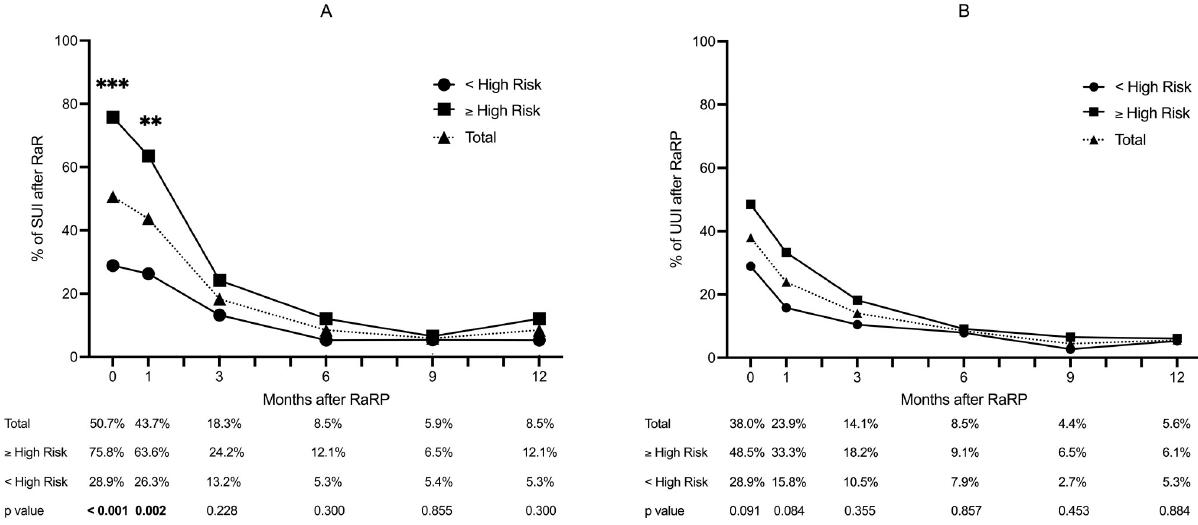
Fig 2. A: Proportion of prostate cancer patients with stress urinary incontinence (SUI) after robot-assisted radical prostatectomy over time. B: Proportion of patients with urgency urinary incontinence (UUI) after robot-assisted radical prostatectomy over time. � p < 0.05, �� p < 0.01, ��� p <